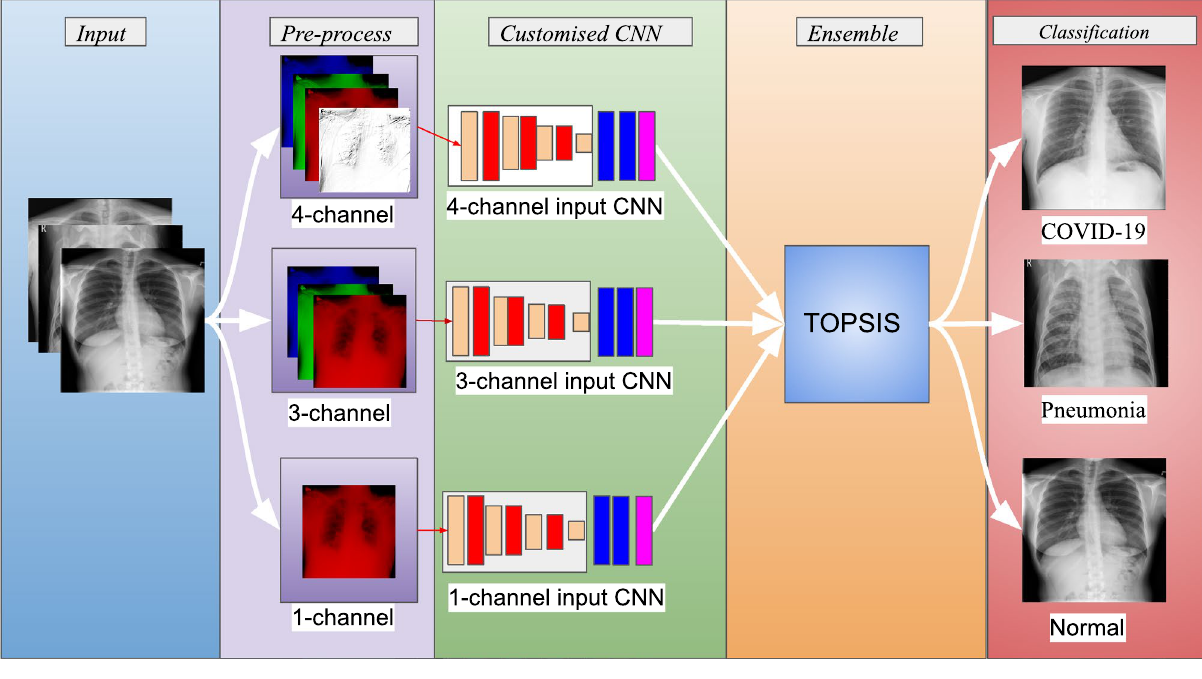
Figure 3. The pipeline for the proposed model. Here, the CNN architecture for all three base classifiers is the same. Images are taken from the public datasets found in 51,52 .